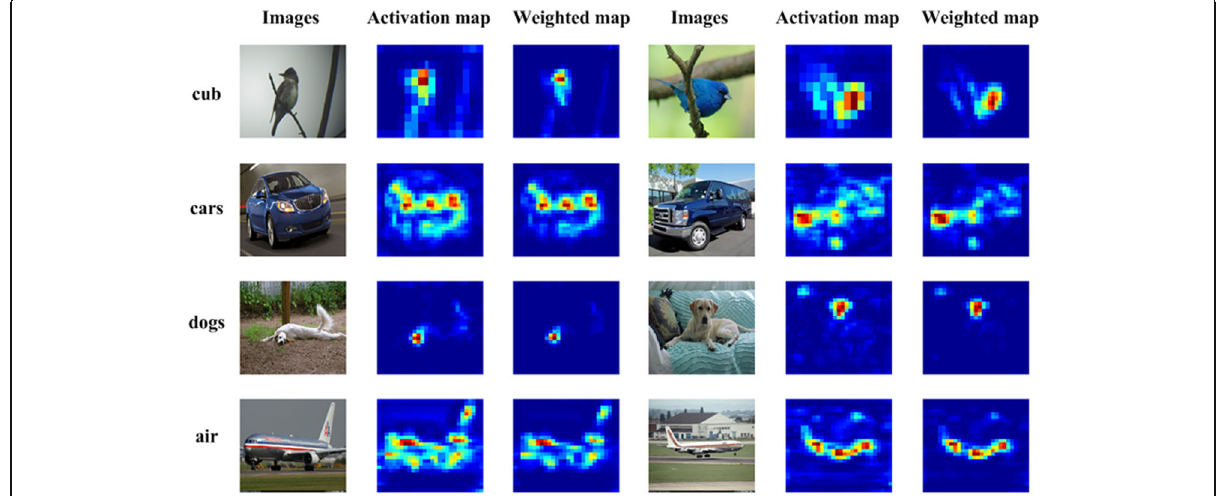
Fig. 5 Examples sampled from four datasets and their corresponding visualized activation map and weighted